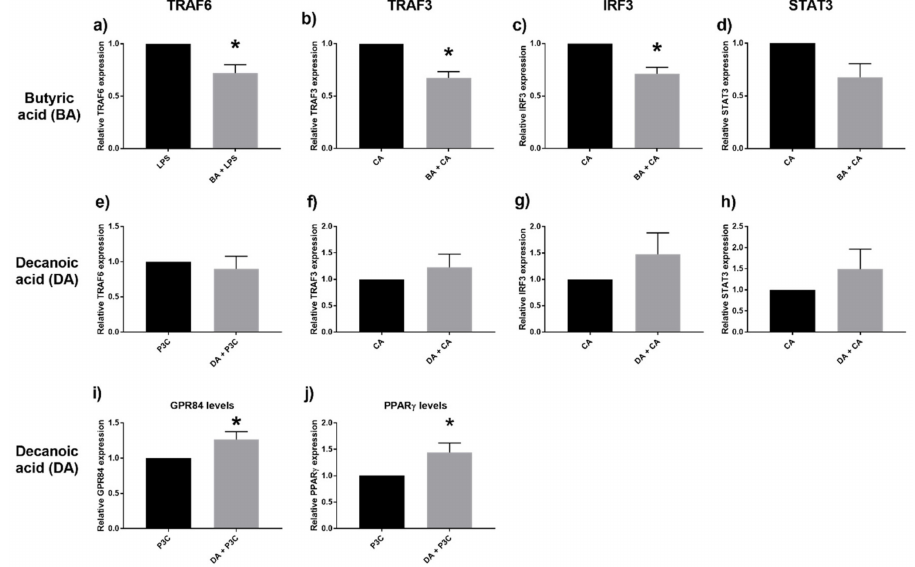
Figure 5. Relative expression of the genes TRAF6, TRAF3, IRF3, and STAT3 after stimulation with butyric acid (BA) 20 µ M and LPS ( a ), CA ( b – d ), compared to decanoic acid (DA) 20 µ M and P3C ( e ), CA ( f – h ). Gene expression levels of GPR84 ( i ) and PPAR γ ( j ) following stimulation with decanoic acid 20 µ M and P3C. Values are presented as mean ± SEM, results from at least 7 subjects were used. * p < 0.05 is the gene expression difference compared to the respective control (LPS/CA/P3C) groups (black bar, normalized to 1), Wilcoxon signed rank test was used to determine